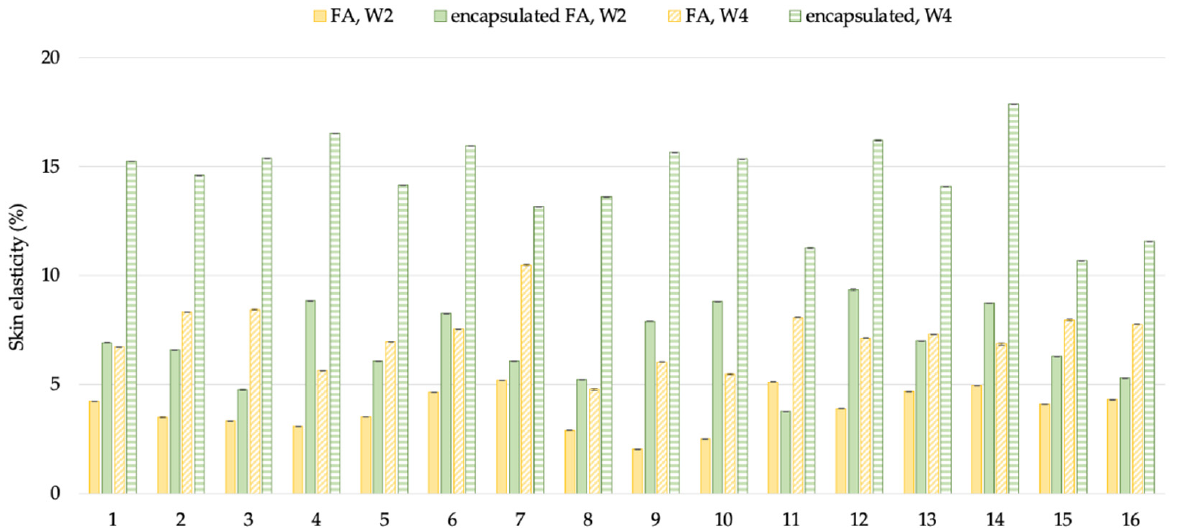
Figure 12. Percent of change in skin elasticity (R7) of each volunteer after application of FA and encapsulated FA creams for 2 weeks.